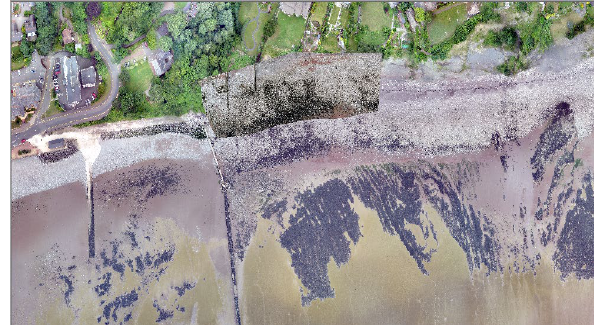
Figure 8 –2015 Penarth Orthomasaic below with Cropped